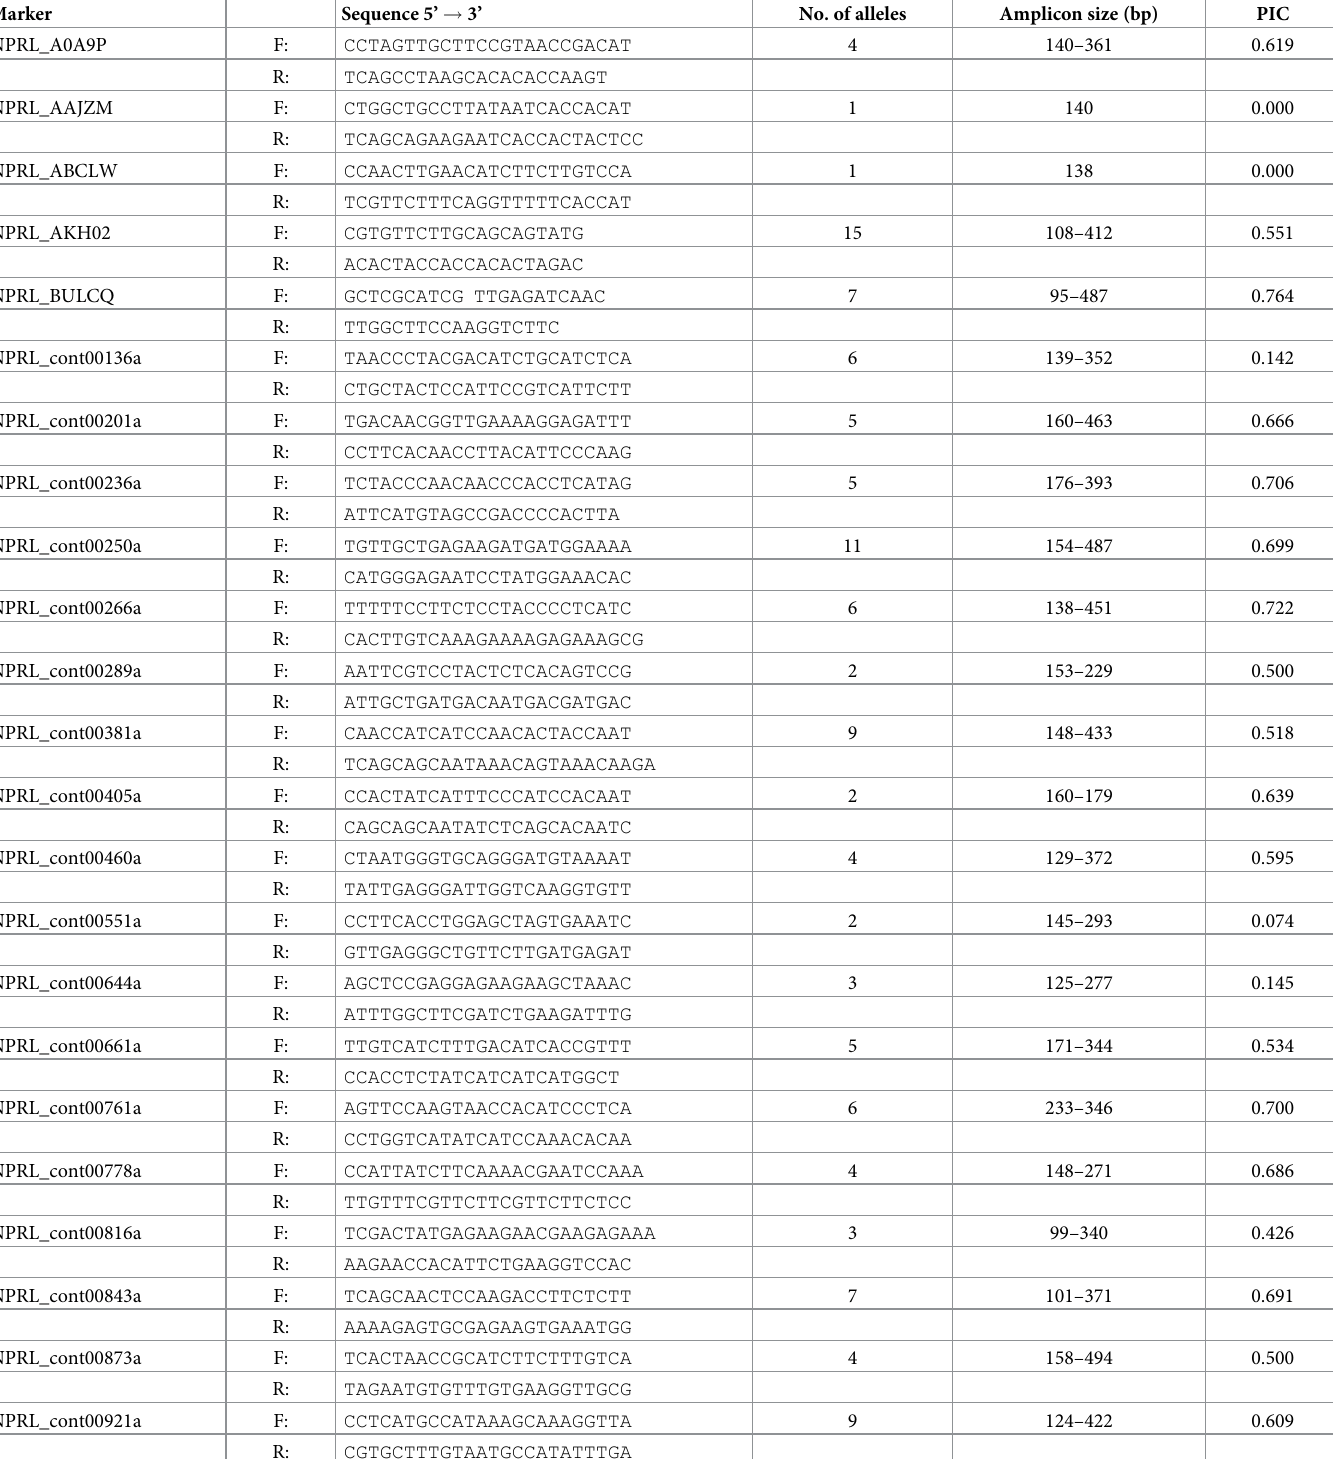
Table 3. Molecular markers used in genotyping and analysis of three peanut crosses between smut-resistant landraces and susceptible elite cultivars. Crosses were JS31411 (I), JS34212 (II) and JS35112 (III). Numbers in parentheses indicate the references for markers: (1) [37], (2) [36], (3) [14], (4) [48], (5) [32], the rest of the markers were recently reported